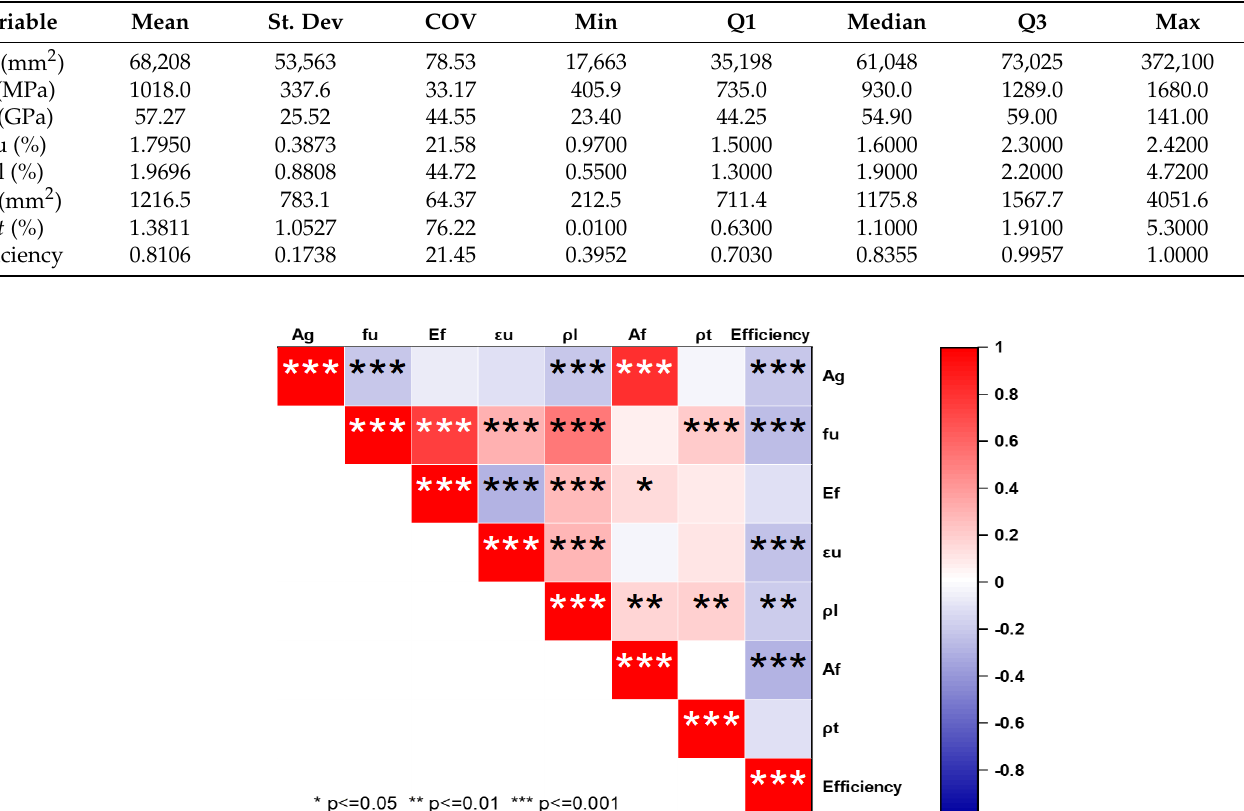
Table 1. Statistical analysis of the parameter for GFRP-based RC columns.